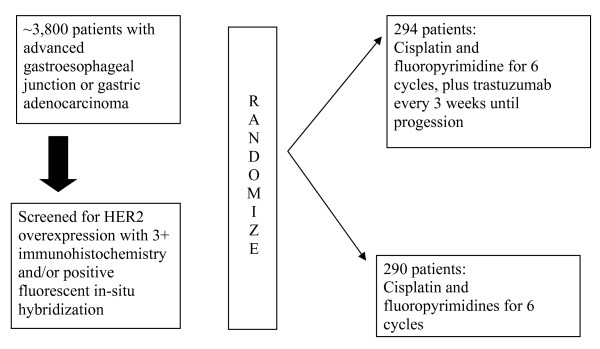
ToGA study design.